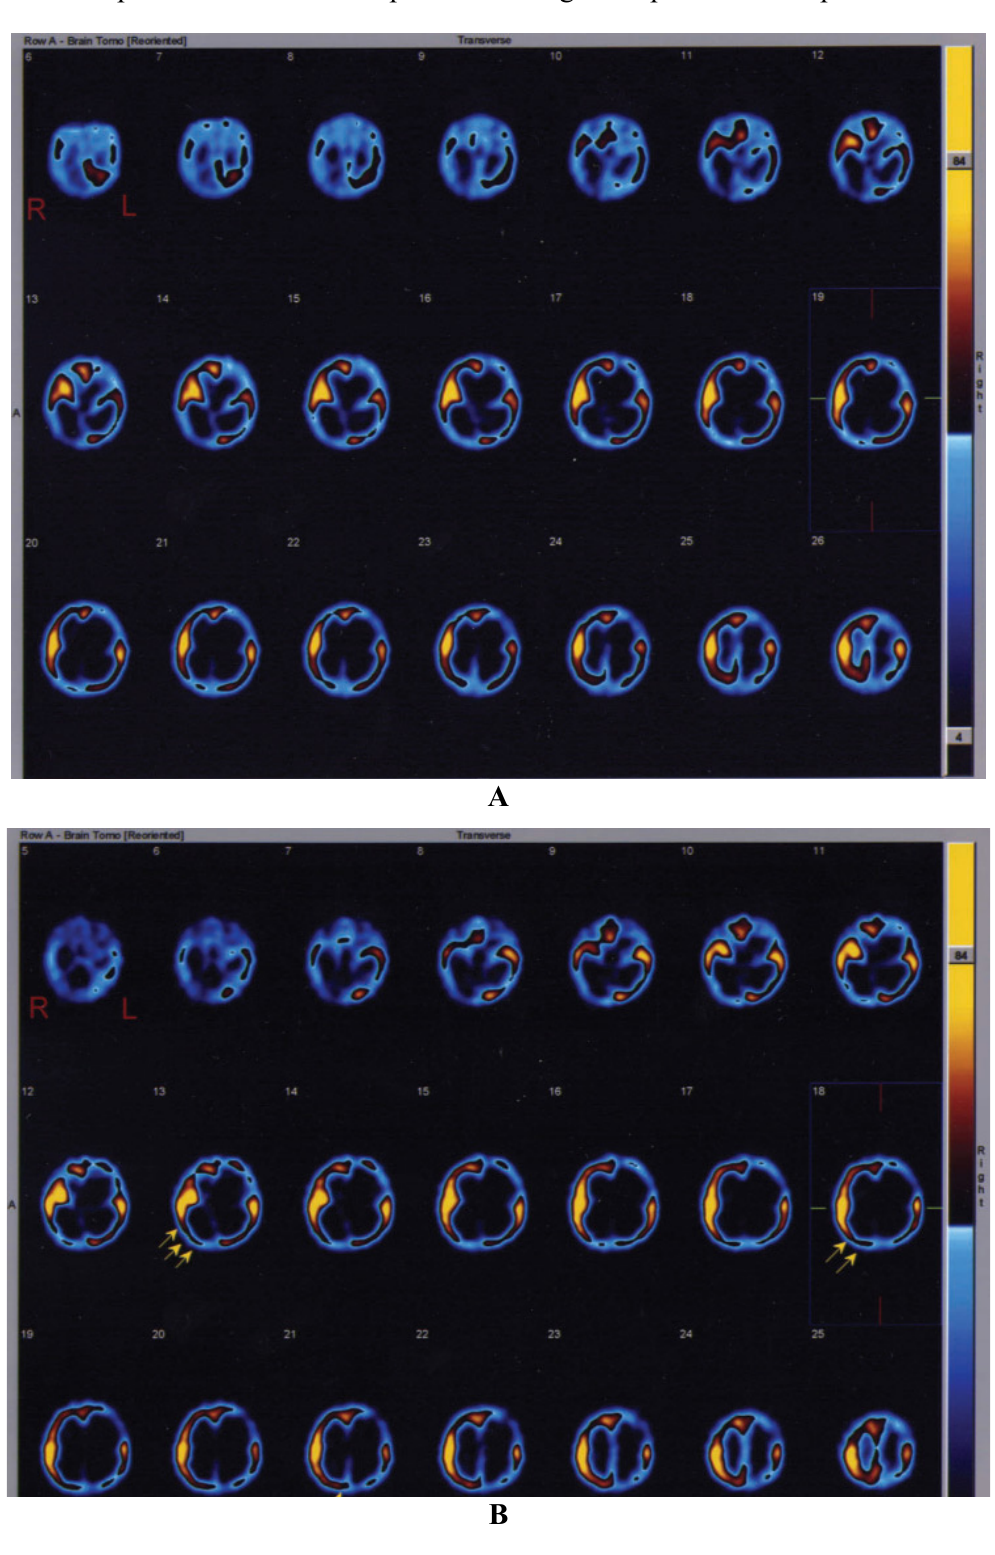
Figure 1. Single-photon emission computed tomography (SPECT) study showing the brain perfusion pattern in the second infant affected by severe hypoxic-ischemic injury. ( A ) Before treatment. ( B ) After intraventricular NGF infusion. The arrows in ( B ) highlight the sites of improvement of cerebral perfusion in right temporal and occipital